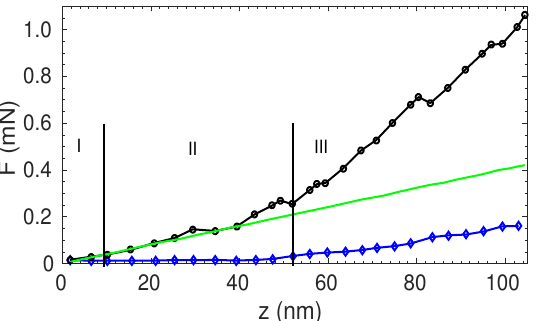
Figure 1. ( a ) Load–displacement curve obtained using MD simulations. Reproduced with permission from Van Vliet et al. [23]; ( b ) load–displacement curve obtained using MD simulations. Reproduced with permission from H-J. Chang et al. [26].